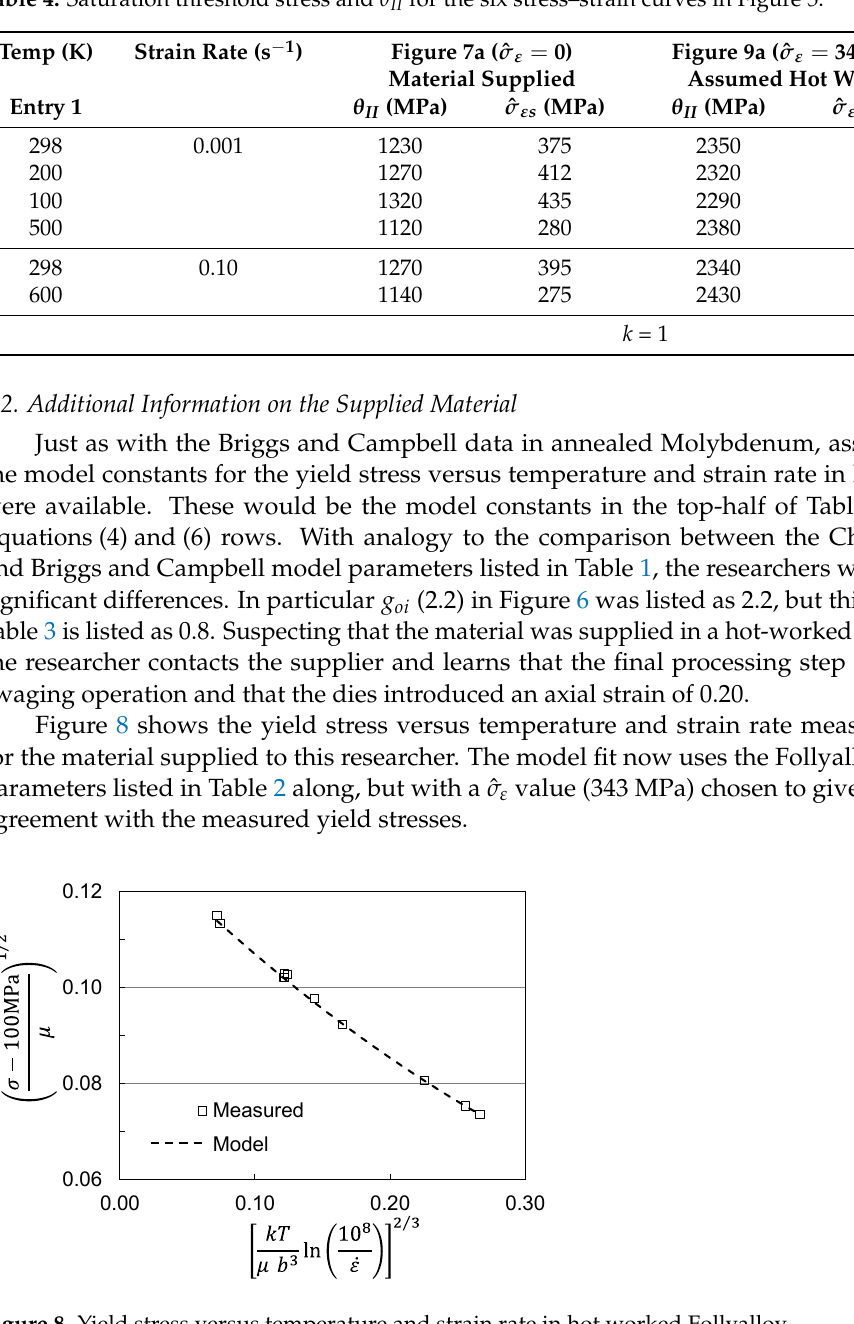
( b ) Figure 9. Assessed evolution for the hot worked material. ( a ) 𝜎(cid:3548) (cid:3084) versus strain according to Equation (4); ( b ) Evolution according to model versus that assuming an initial strain of 20%. The curve shown in Figure 9b can be fit to the model evolution law, Equation (4) to estimate the fitting parameters θ II and 𝜎(cid:3548) (cid:3084)(cid:3046) for each of the test conditions. The resulting values are included along with the model parameters for Equations (2) and (3) in Table 4 in the column labeled “Assumed Hot Worked”. Figure 10 shows the plot of saturation stress versus temperature and strain rate according to Equation (5). There are significant differences between the evolution equation model parameters noted in the two columns. However, there are only minor differences between the model parameters for Follyalloy listed in Table 2 and those listed in Table 3 for the “Assumed Hot Worked”.